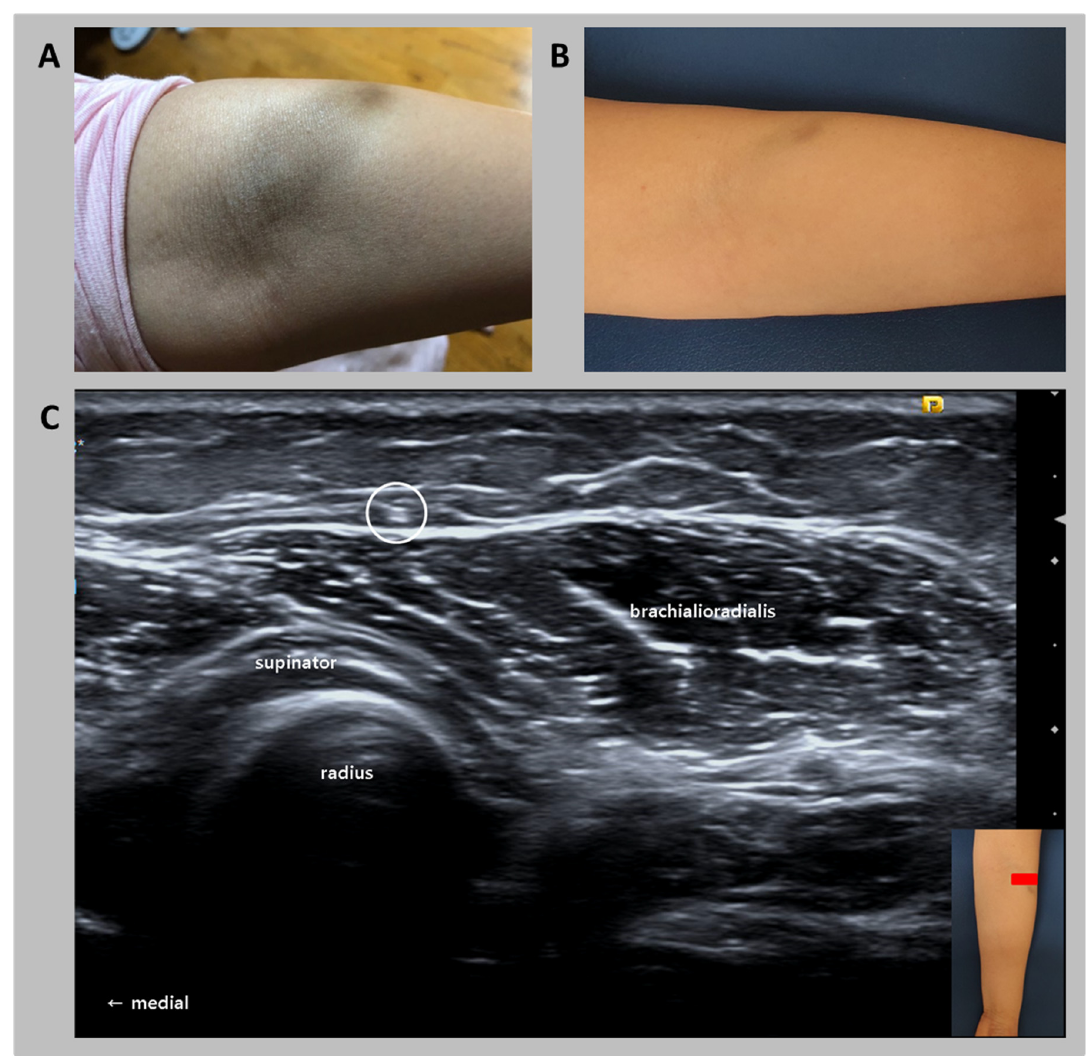
Figure 1. ( A ) One day after the intravenous ferric carboxymaltose infusion. The area around the left cubital fossa was largely stained by the extravasated iron. ( B ) Sixteen months after the infusion, the staining had faded remarkably but with some staining remaining. ( C ) The ultrasonography image shows a lateral antebrachial cutaneous nerve (in the circle) under the stained area in the anterolateral elbow and proximal forearm. A 41-year-old woman presented with tingling pain over her left forearm. Around 16 months before, the patient received an intravenous ferric carboxymaltose infusion for iron deficiency anemia. Within minutes of commencing the infusion, pain around the cannula insertion site occurred. The infusion was stopped, and the nurse drew out the cannula. By the following day, a painful brown pigmentation, 4.0 × 8.5 cm in size, had developed on the lateral side of the cubital fossa around the cannula insertion site (Figure 1A). After 16 months, a large part of the staining had fade, with 2.0- × 4.3-cm staining remaining (Figure 1B). In addition, when the stained area was compressed by an external force, the patient felt a tingling pain on her left lateral forearm. Motor and sensory deficits were not observed. Ultrasonography (US) imaging (18-MHz linear transducer; S2000, Siemens, Seoul, South Korea) could not visualize the remaining iron in the subcutaneous tissue. However, when the stained area was swept with the transducer, the patient described a tingling pain on her left lateral forearm, equal to her usual pain (Figure 1C). US imaging revealed a lateral antebrachial cutaneous nerve (LACN) under the stained area, and the painful area at the forearm where the US transducer passed over was consistent with the region innervated by the left LACN. Accordingly, the patient’s pain seemed to have resulted from the compression of the left LACN by the leaked iron during the intravenous infusion. Nevertheless, the patient perceived pain